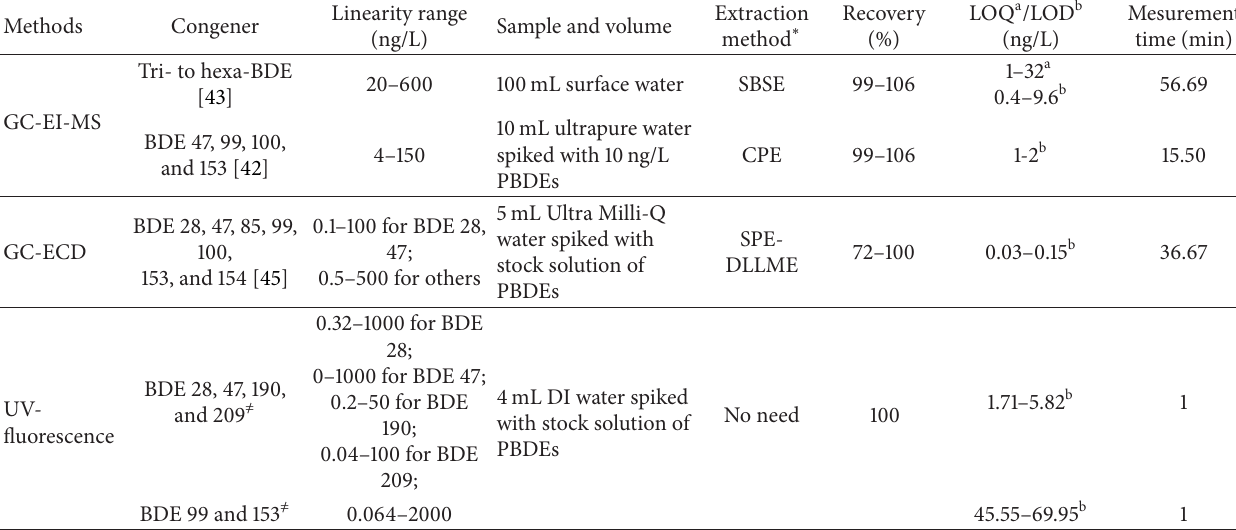
Table 2: Comparison of fluorescence and GC or GC-EI-MS for determining PBDEs in aqueous solutions.